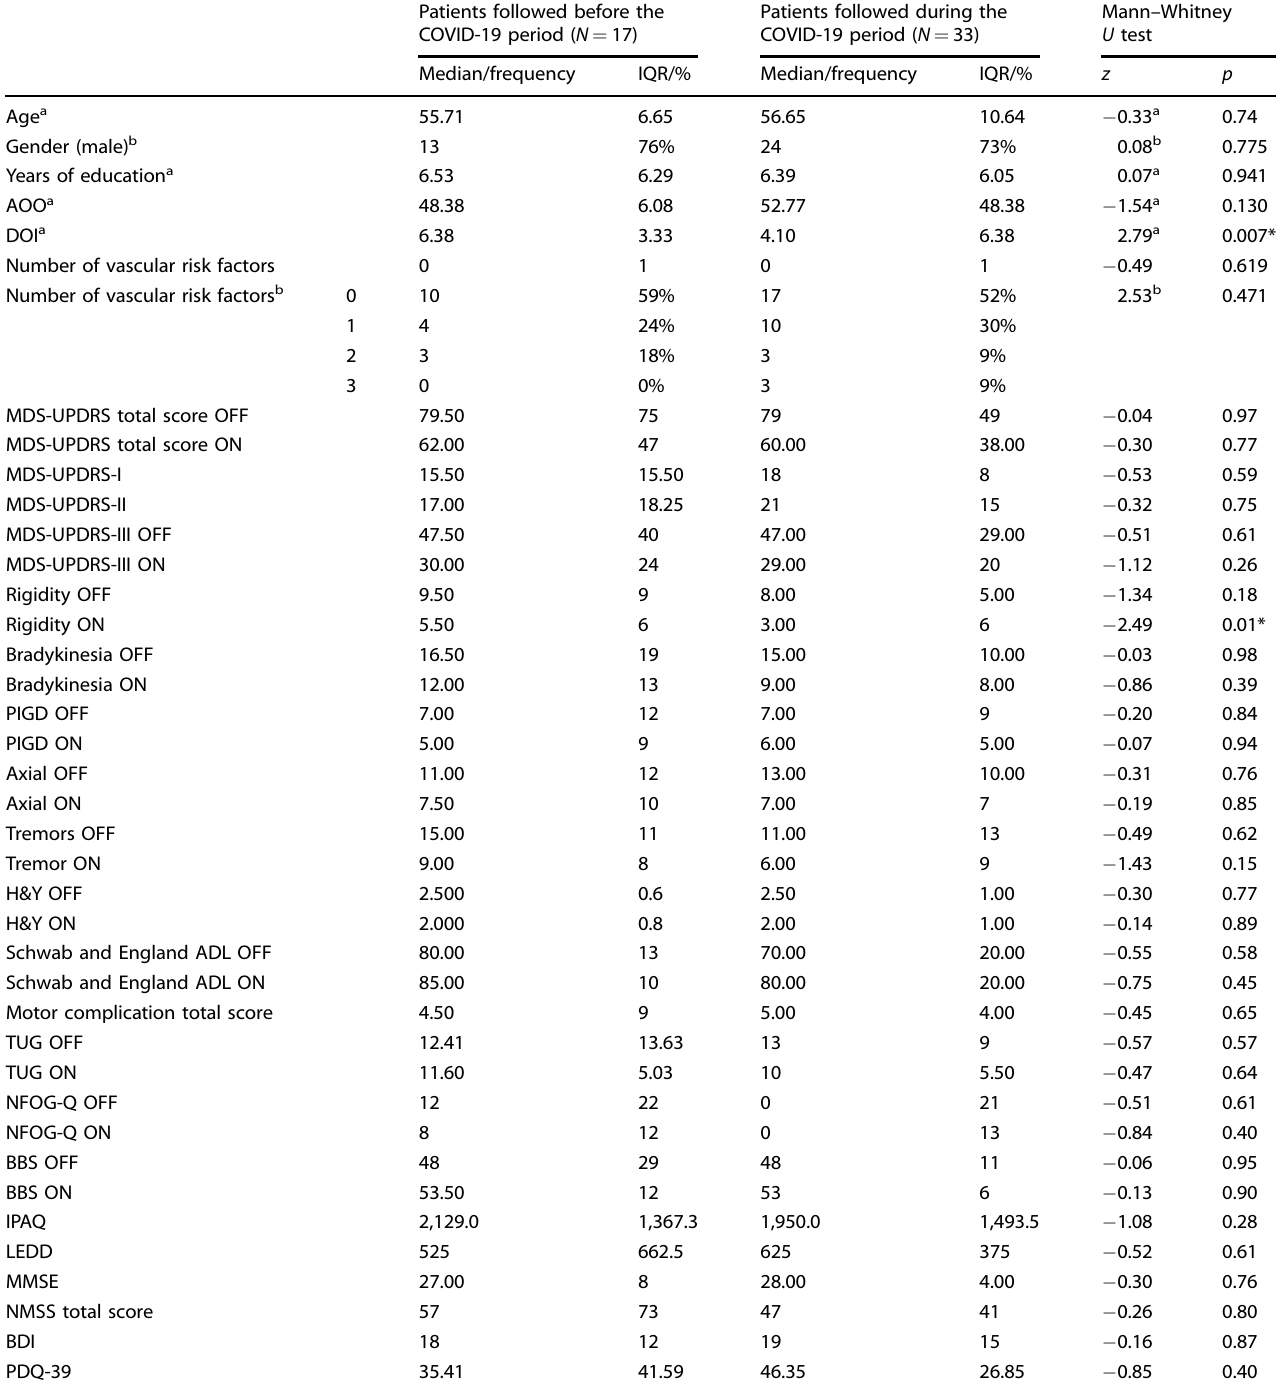
Table 1. Baseline characteristics of patients with PD who were followed before and during the COVID-19